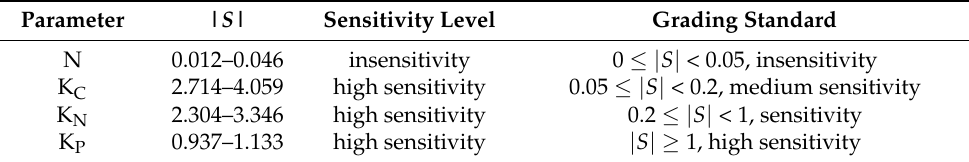
Table 2. Analysis of parameter sensitivity.